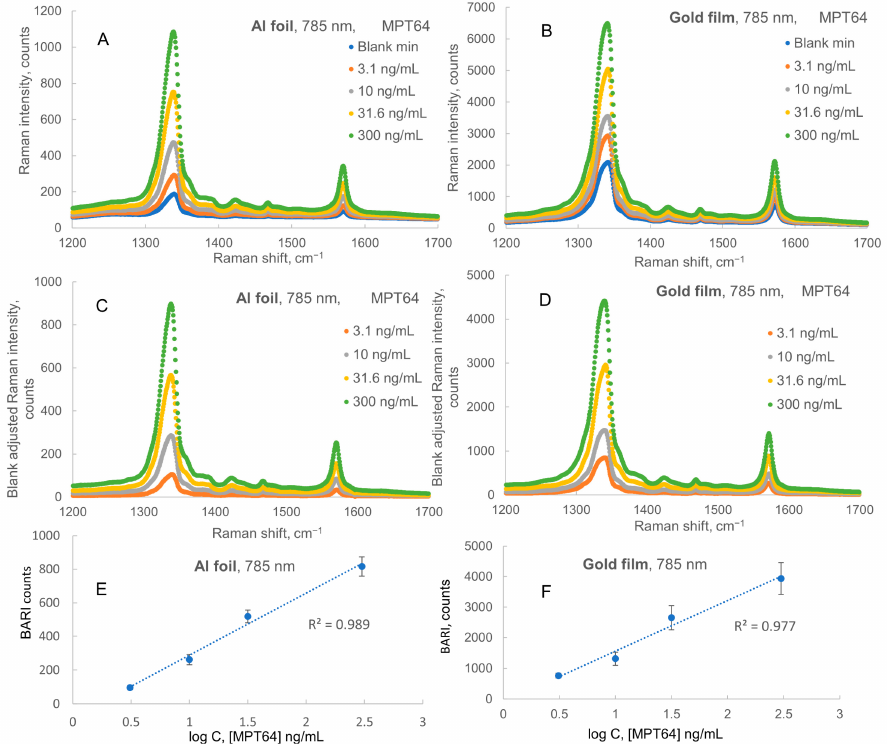
Figure 2. Raman spectra and calibration plots for sandwich immunoassay of MPT64 on Al foil and gold film with 785 nm excitation. ( A , B ) Spectra of Raman intensity on Al foil and Au film, respec- tively. ( C , D ) Blank-adjusted Raman intensity on Al foil and Au film, respectively. ( E , F ) Logarithmic calibration plots on the same substrates, respectively.